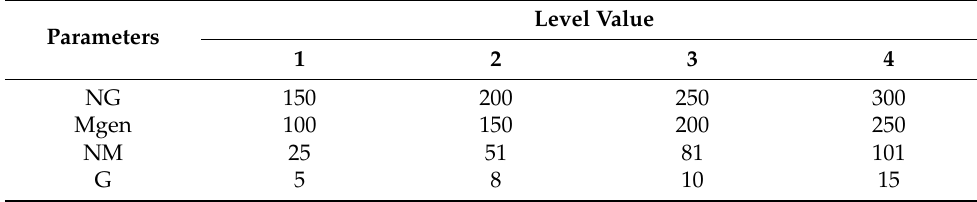
Table 3. Parameter level of